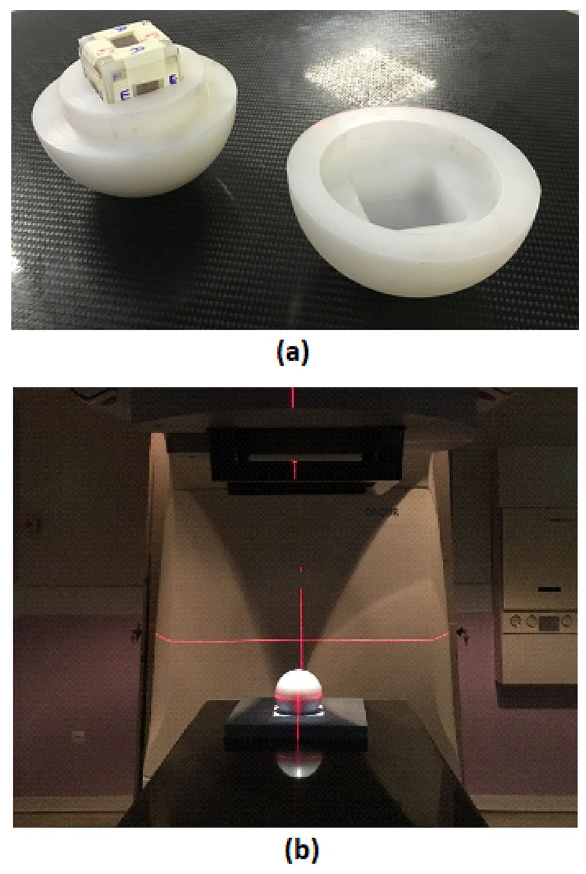
Figure 2. ( a ) Halves of a PE sphere with a PE cube embedded (with 6 PCTD/ 10 B detectors on the sides); and ( b ) the assembled PE sphere with embedded PE cube as placed at the isocenter of the medical accelerator beam to be exposed.